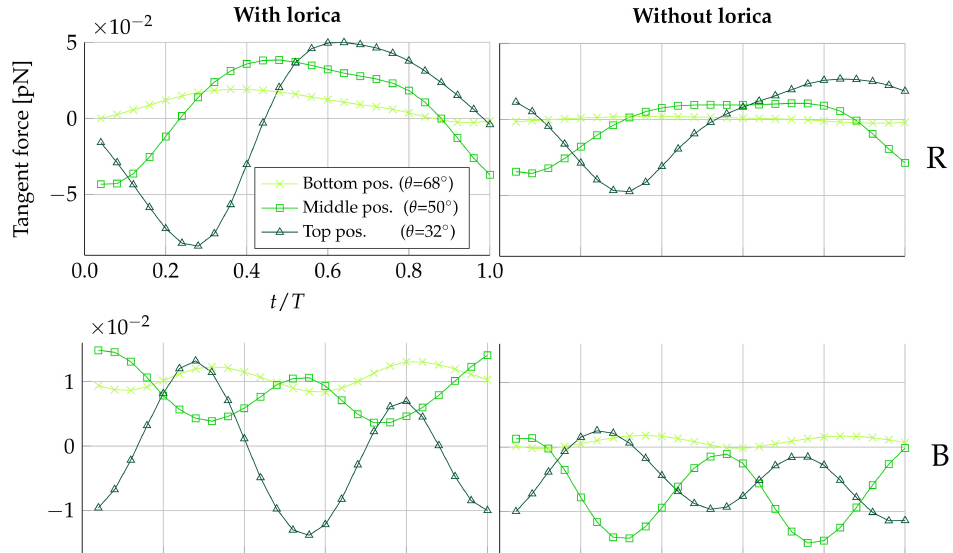
Figure 4. Tangent force distribution on medium-sized prey during one beat cycle with period T . Here, negative forces are in the direction of the cell. The left-hand column of plots is simulated with the presence of the lorica, and the right-hand column of plots is simulated without. The first row of plots displays forces on the right (R) side of the the collar, and the second row displays forces on the back (B) of the